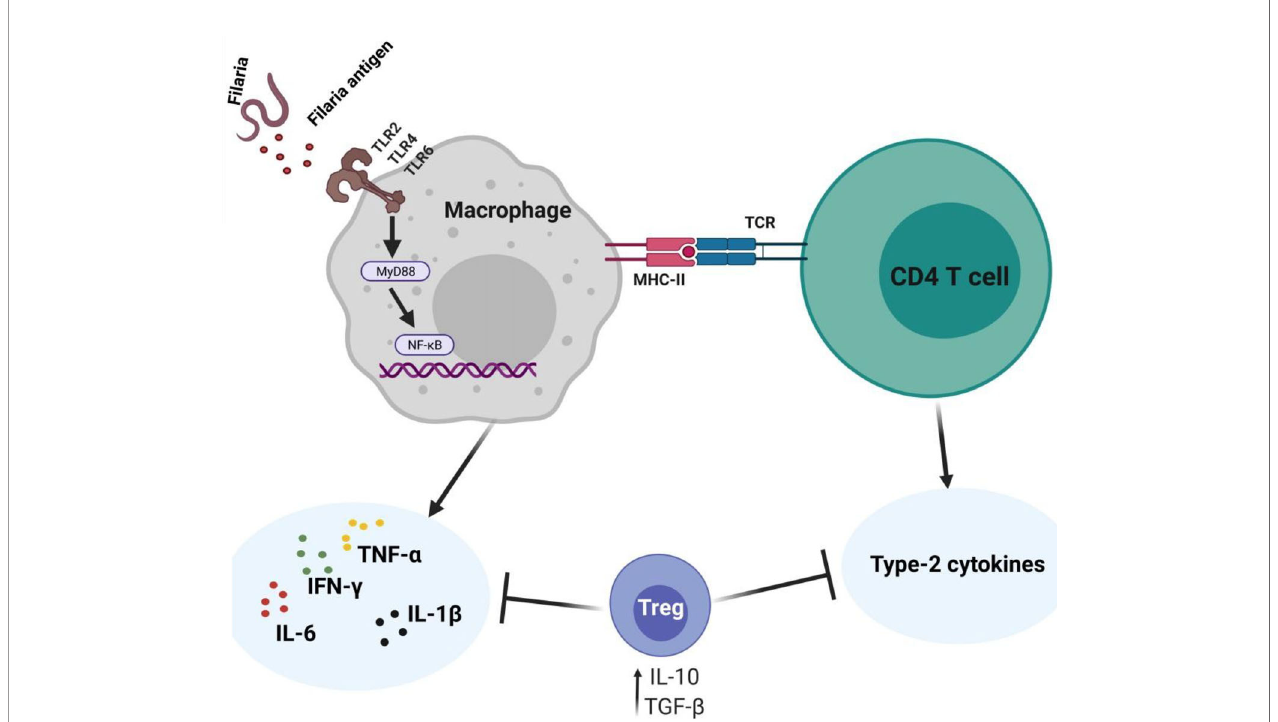
FIGURE 2 | Cytokine expressing pro fi les against fi laria and immunoregulation. The fi laria and their endosymbiont interact with TLRs on the APCs to induce pro- in fl ammatory responses via NF-kB signaling. The CD4 + T cells expressing type-2 cytokines are involved in parasite clearance. Regulatory T cells are simultaneously involved in modulating the Th1/Th2